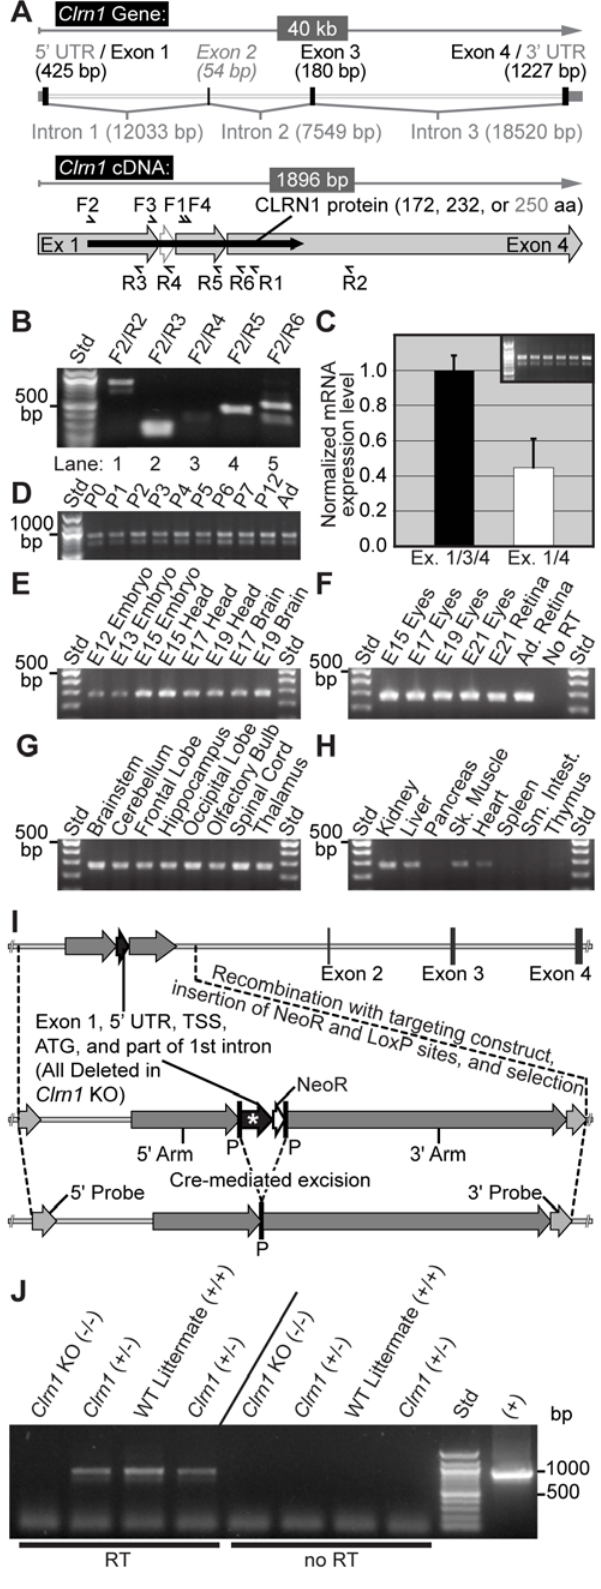
Figure 1. Clrn1 RT–PCR analysis in mouse retina and KO mouse generation. (A) Schematic diagram illustrating the intron/exon structure of the murine Clrn1 gene, and the structure of the